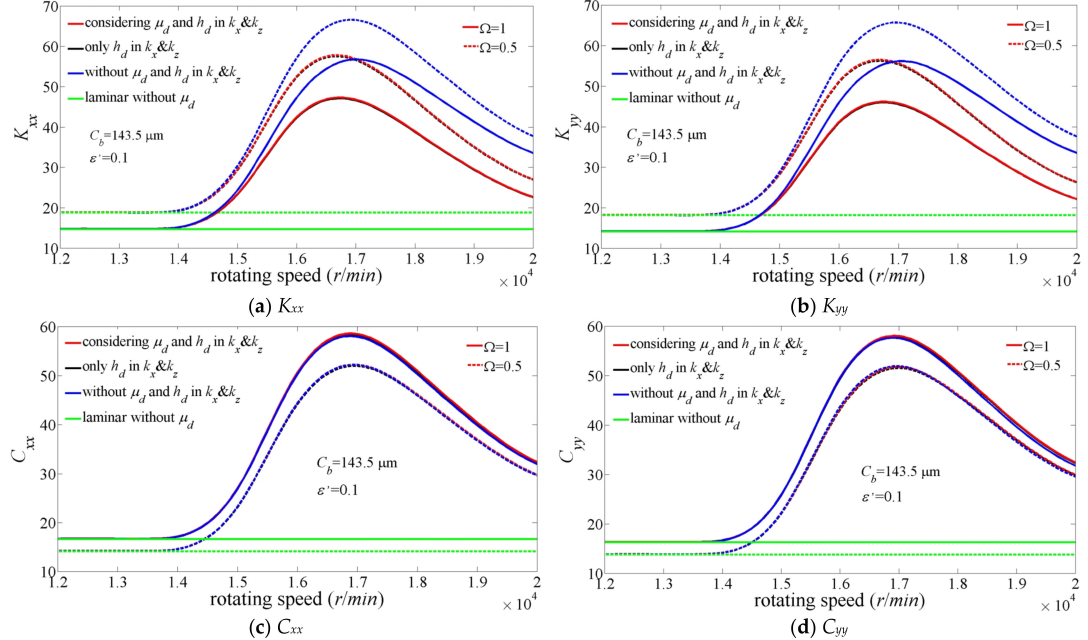
Figure 5. Variations of the dimensionless equivalent dynamic coefficients with rotating speed at assembled clearance C b = 143.5 µ